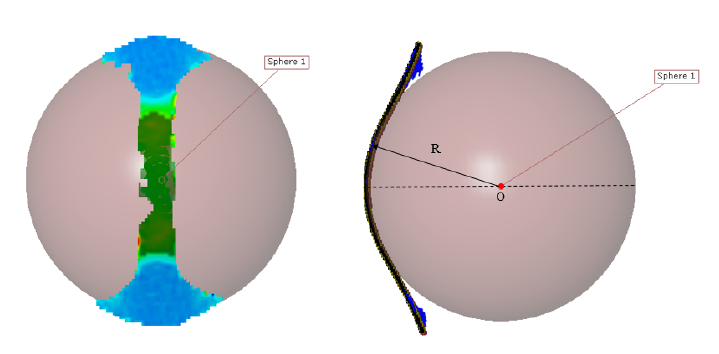
Figure 11. Definition of strains in the layers of the sheet: Outer surface ( (cid:101) O Middle layer ( (cid:101) M ); i = 1,2 are the principal directions. i